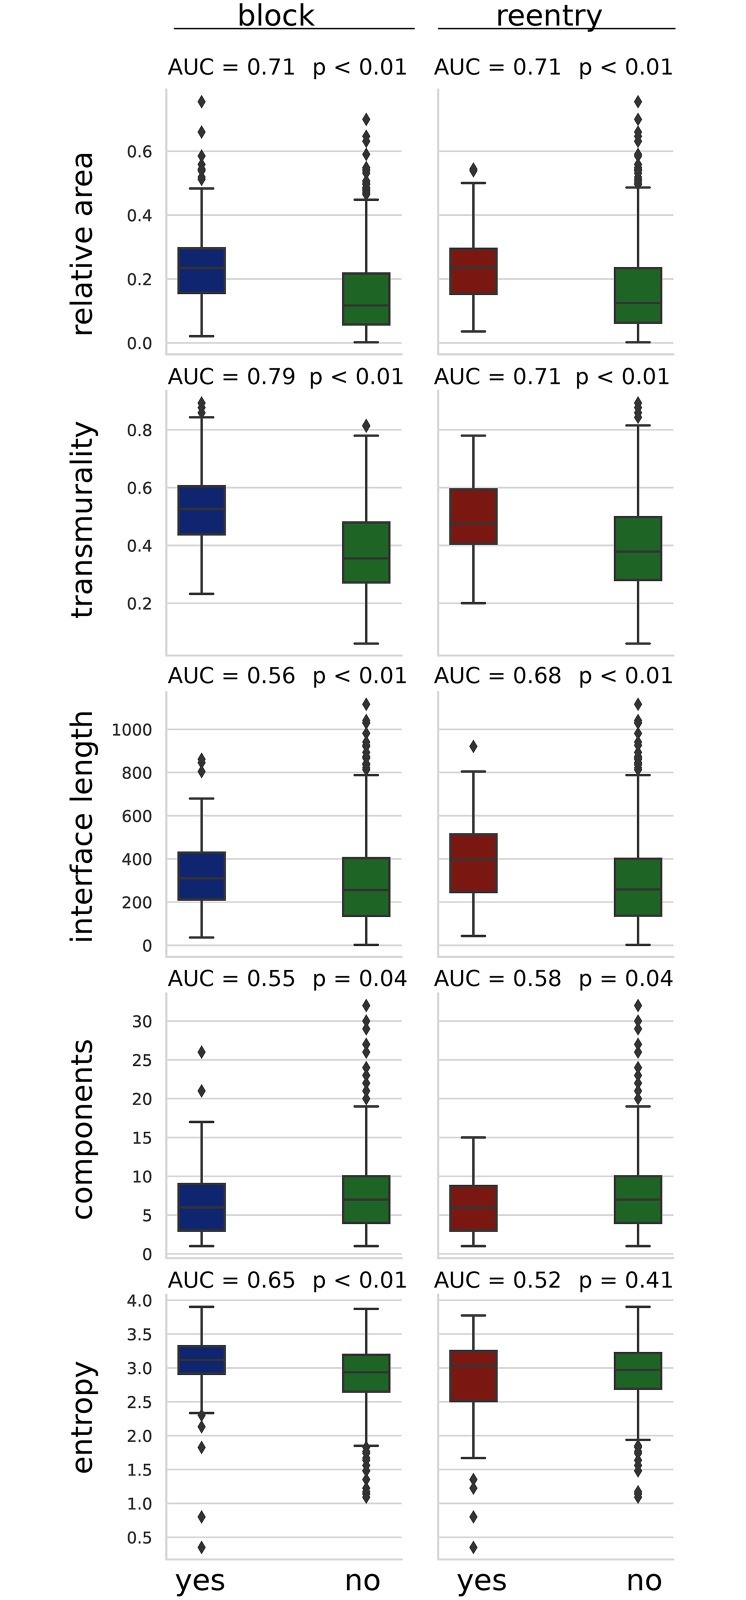
Boxplots showing the distribution of image feature values for images that had at least one simulated block vs no block (right column) or at least one simulated reentry vs no reentry (left column).AUC scores are area under curve in a receiver operating curve analysis for each feature’s ability to predict either reentry or block for a given image.